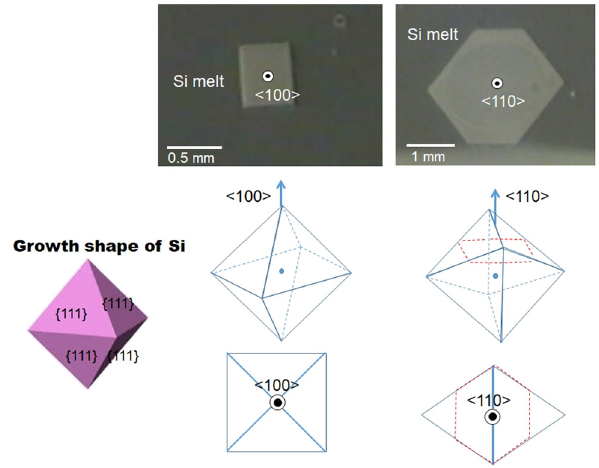
Figure 3: Growth shape for a normal Si crystal with di ff erent upper orientations. The shape is bounded by { 111 } planes because they have the lowest growth rate [ 73,77 ] .